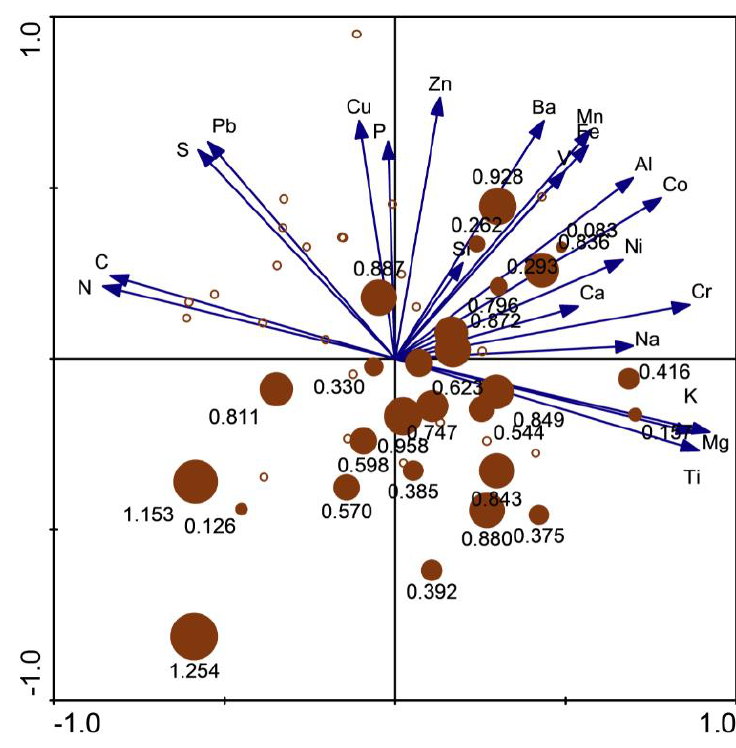
Figure 11. PCA plot of the top (recent, human-impacted) samples, showing the peat extraction percentages. Reference lakes (no peat extraction) concentrate in the upper left quadrant of high organic content.